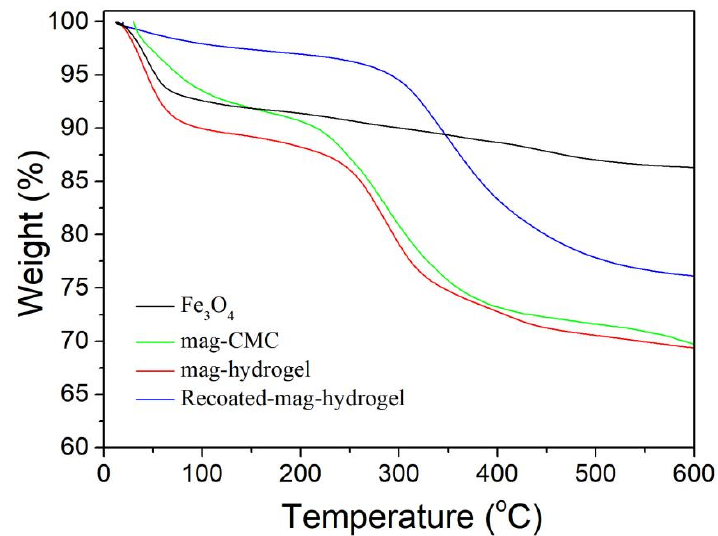
Figure 6. Thermogravimetric curves of Fe 3 O 4 and magnetic nanocomposites.